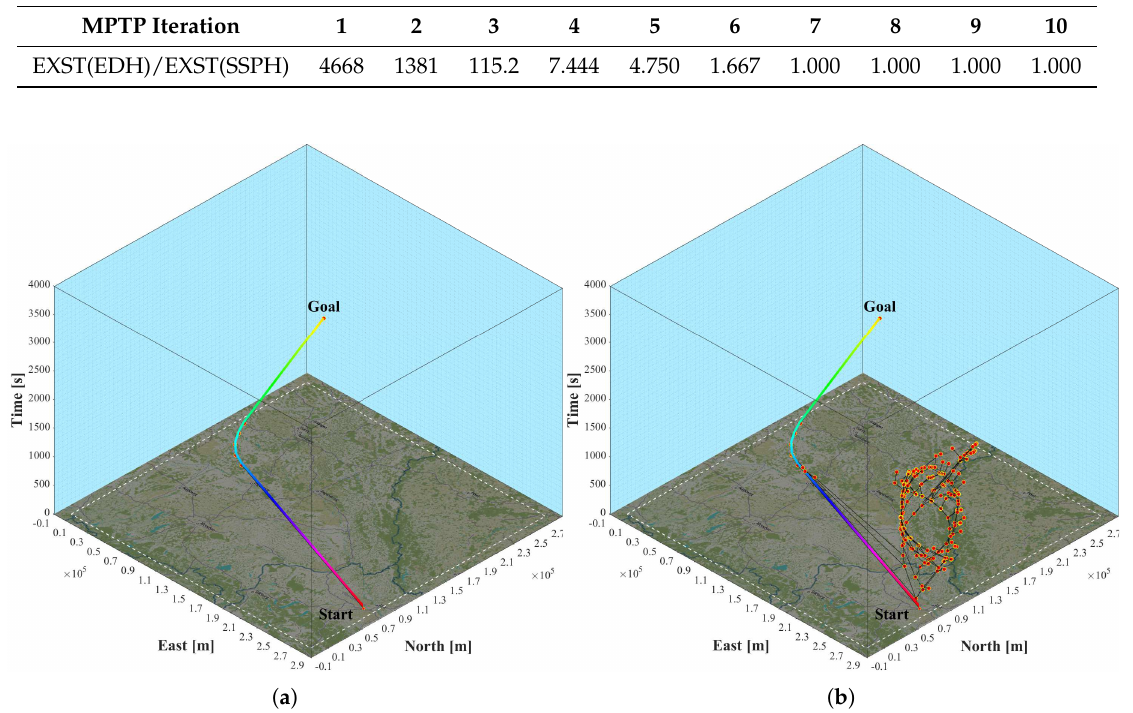
Table 19. Ratio between explored states for A* with EDH vs. A* with SSPH , if the aircraft can turn left and right.